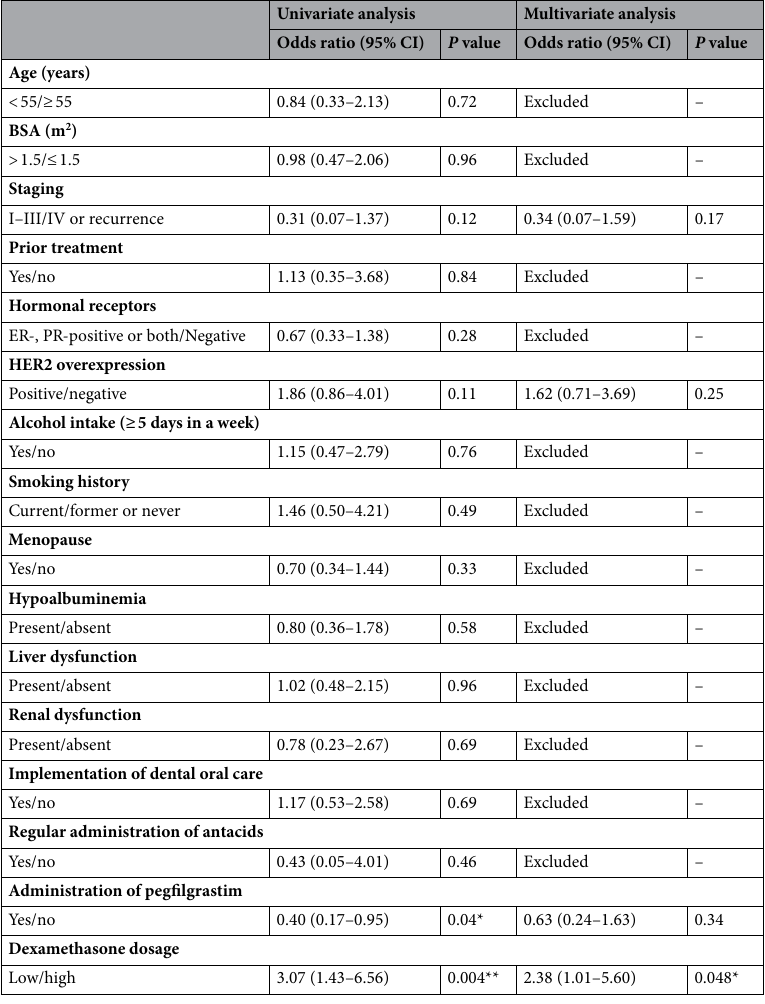
Table 2. Univariate and multivariate analyses of the risk factors associated with the incidence of all-grade oral mucositis in the first cycle. Liver dysfunction: grade 1 or higher aspartate aminotransferase,